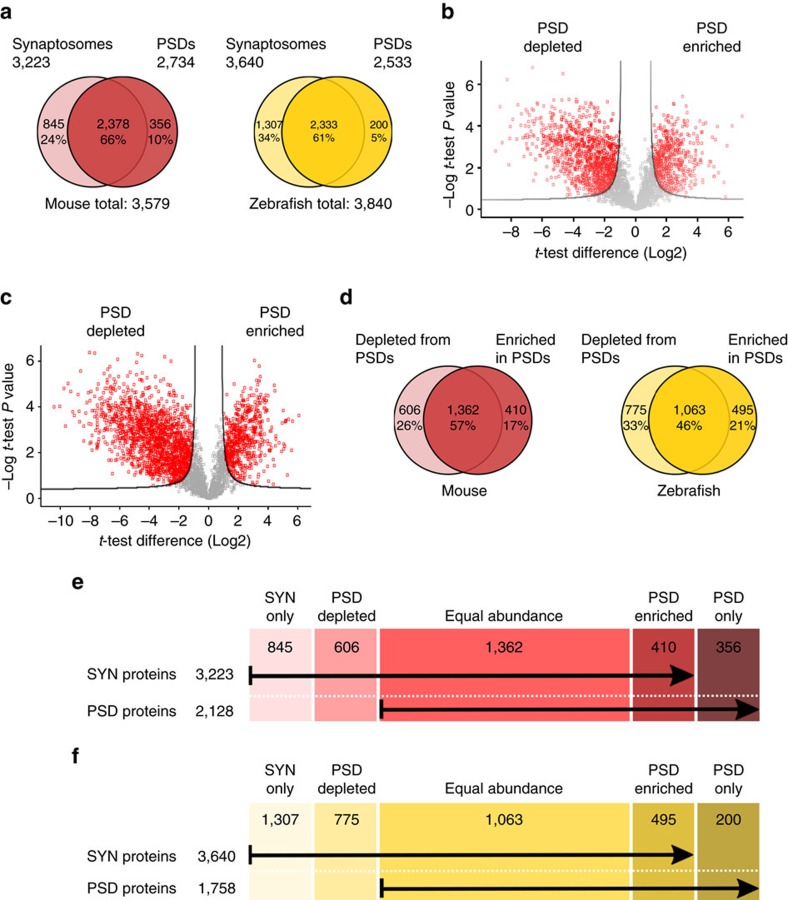
Mouse and zebrafish synaptic proteome.(a) Venn diagrams of mouse (red) and zebrafish (yellow) proteins identified in synaptosomal and PSD preparations, indicating the percentage of proteins found in both fractions. The total number of proteins identified in each species is also indicated. (b,c) Volcano plots showing quantitative enrichment and depletion of proteins between synaptosomes and postsynaptic densities purified from mouse (b) and zebrafish brain (c). Enriched or depleted proteins were identified from statistical analysis of triplicate PSD and synaptosome data sets for each species using t-testing and a Permutation-based false discovery rate of 0.05. (d) Venn diagrams of mouse (red) and zebrafish (yellow) proteins found depleted or enriched in the PSD when compared with the synaptosomal fraction. The percentage of proteins found with equal abundance at the synaptosomal and PSD fraction is also indicated. (e) Scheme indicating the number of mouse synaptosomal and PSD proteins found only in one of the two fractions, depleted or enriched at the PSD or found in equal abundance in both fractions. (f) Scheme indicating the number of zebrafish synaptosomal and PSD proteins found only in one of the two fractions, depleted or enriched at the PSD or found in equal abundance in both fractions.